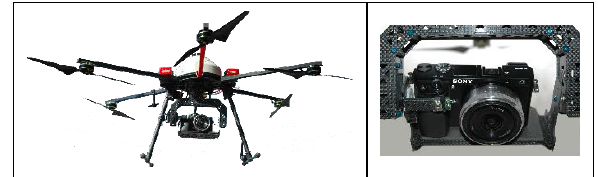
Figure 3. The UAS and camera used